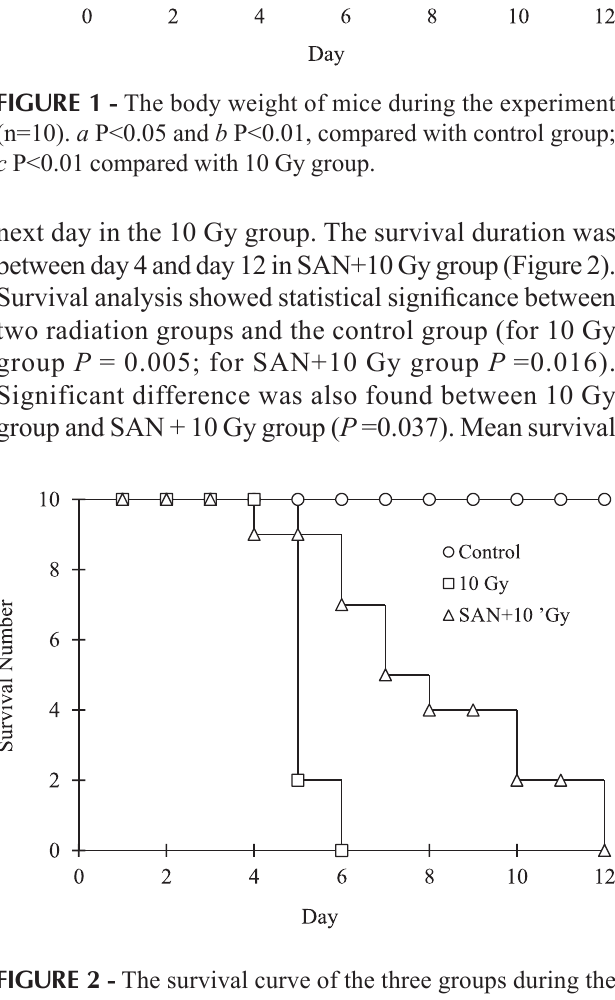
FIGURE 2 - The survival curve of the three groups during the experiment